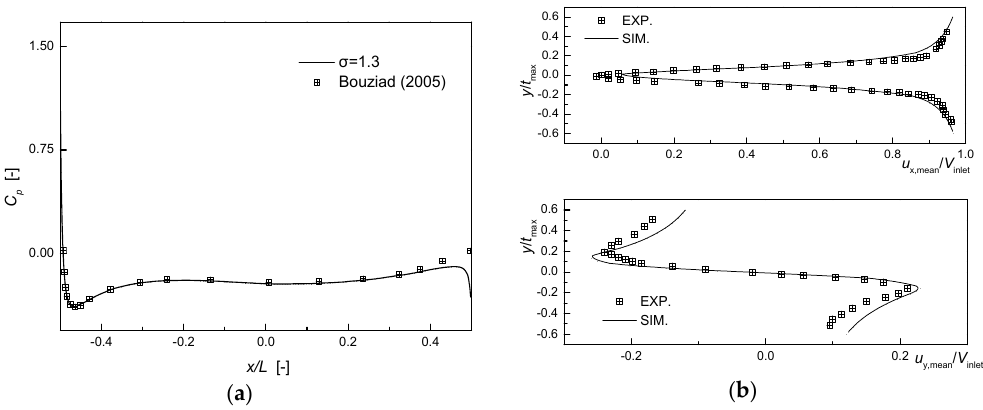
Figure 3. Comparison of: ( a ) numerical mean pressure coefficient, C p , with the vortex panel method as a function of the dimensionless position, x/L ; ( b ) numerical mean normalized horizontal and vertical velocities, u x ,mean / V inlet and u y ,mean / V inlet respectively, with experimental results at different vertical dimensionless positions, y / t max .